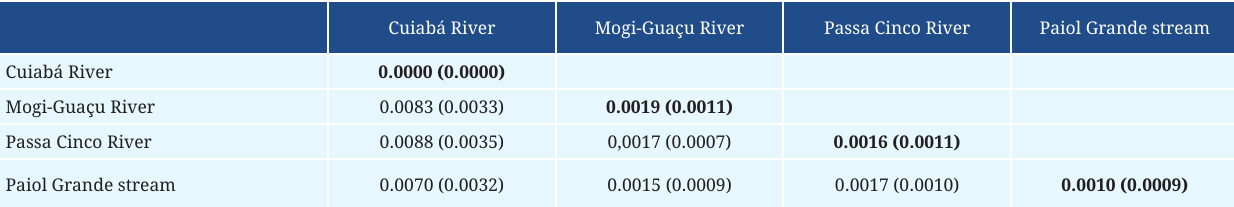
TABLE 2 | Estimates of evolutionary divergence over sequence pairs among groups and standard error in populations of Parodon nasus . Bold values in main diagonal show the intraspecific genetic distance. The number of base substitutions per site from averaging over all sequence pairs between groups is shown. Kimura-2-Parameters genetic distance means and standard error. Analyses were conducted using the Kimura 2-parameter model. The analysis involved 19 nucleotide sequences. Codon positions included were 1st+2nd+3rd+Noncoding. All positions containing gaps and missing data were eliminated. There were a total of 631 positions in the final dataset.